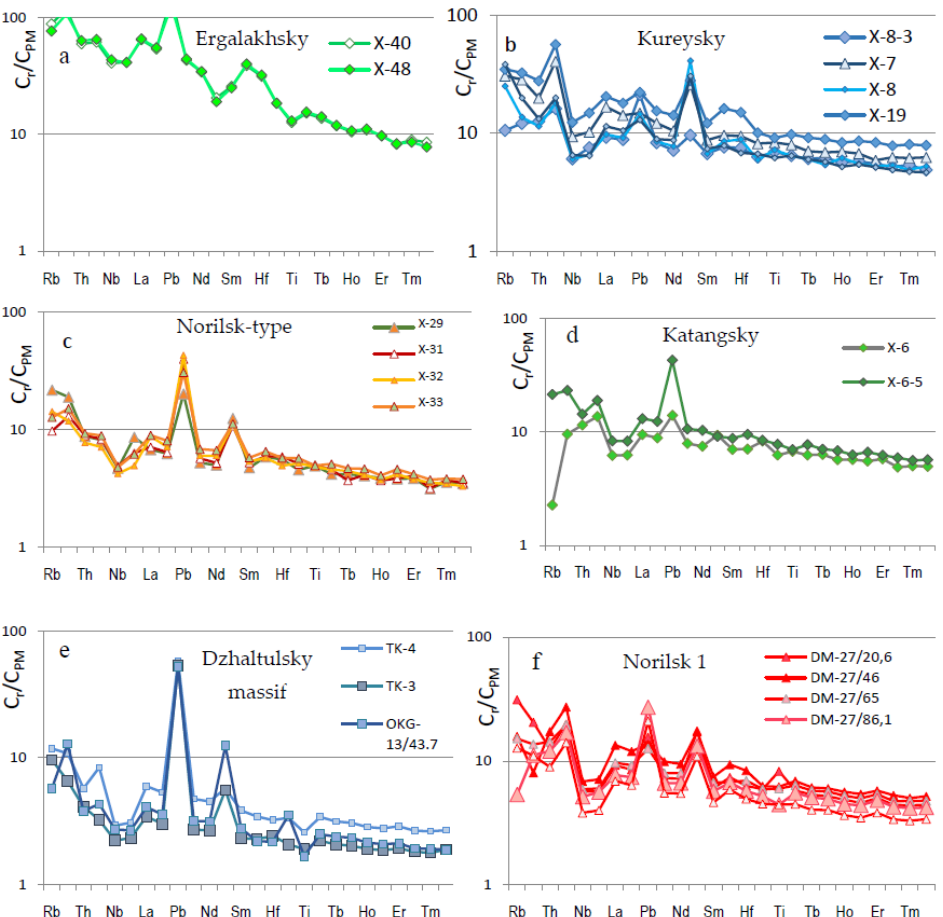
Figure 15. Spider-diagrams for intrusive rocks of the ( a ) Ergalakhsky complex, ( b ) Kureysky complex, Khalil intrusion, ( c ) Norilsk type Intrusion 3, ( d ) Katangsky complex, ( e ) Dzhaltulsky massif and ( f ) Norilsk 1 intrusion.